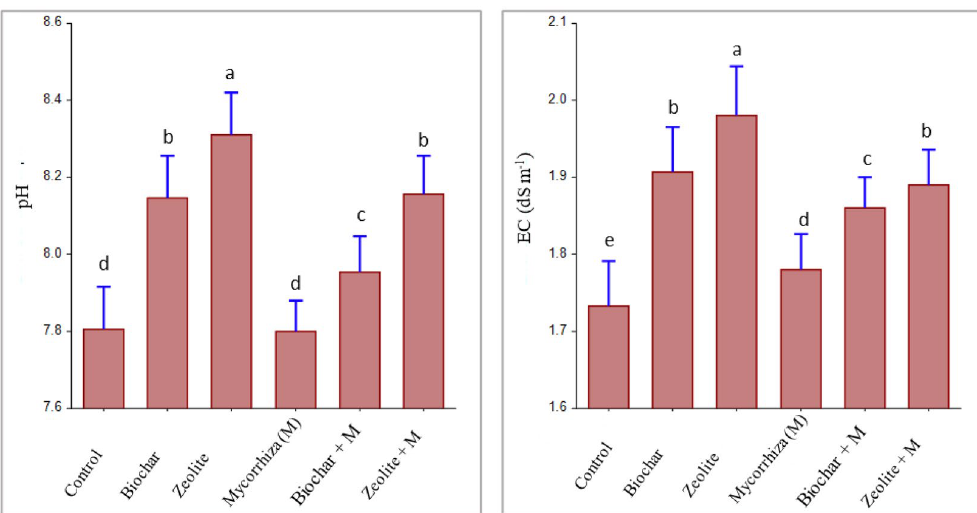
Figure 3. Effect of soil amendments and mycorrhiza on soil pH and EC. Error bars are the standard deviation. (Different letters above bars represent significant differences at P < 0.05 among various treatments. Bars with the same letters represent no significant